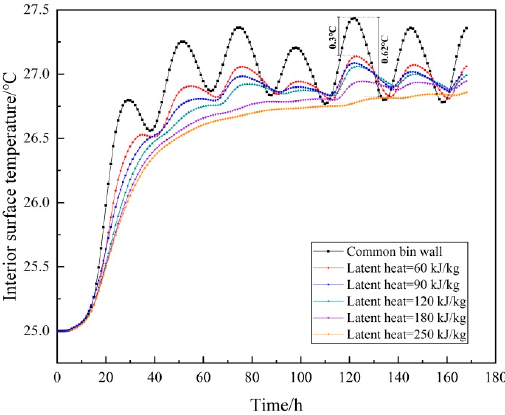
Figure 5. T in distribution with different latent heats of PCM.